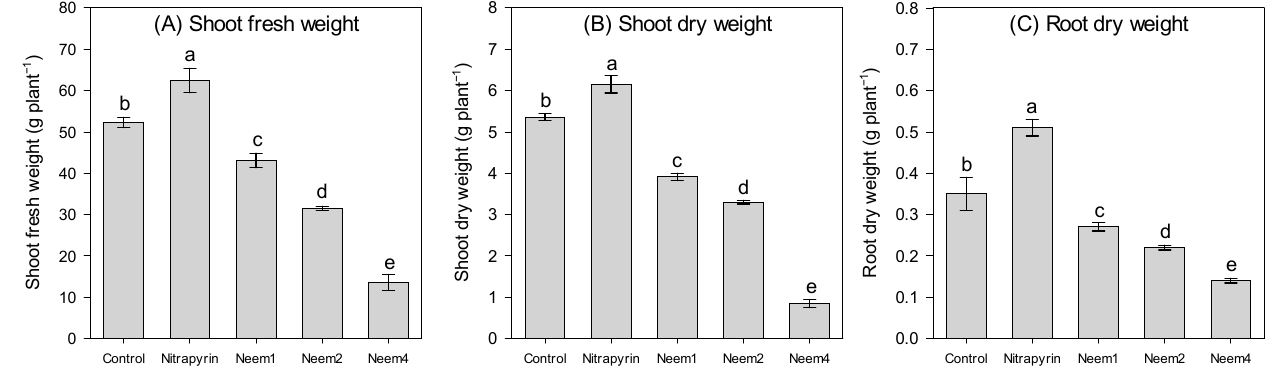
Figure 2. Lettuce yields: ( A ) shoot fresh weight, ( B ) shoot dry weight, and ( C ) root dry weight, as affected by different nitrification inhibitors. Bars with different letters indicate statistical differences ( p ≤ 0.05; Fisher’s least significant difference test). Error bars represent the standard deviation. Neem1, Neem2, and Neem4 = neem leaf extract based on the dry weight of the raw material at rates of 1, 2, and 4 g kg − 1 soil.